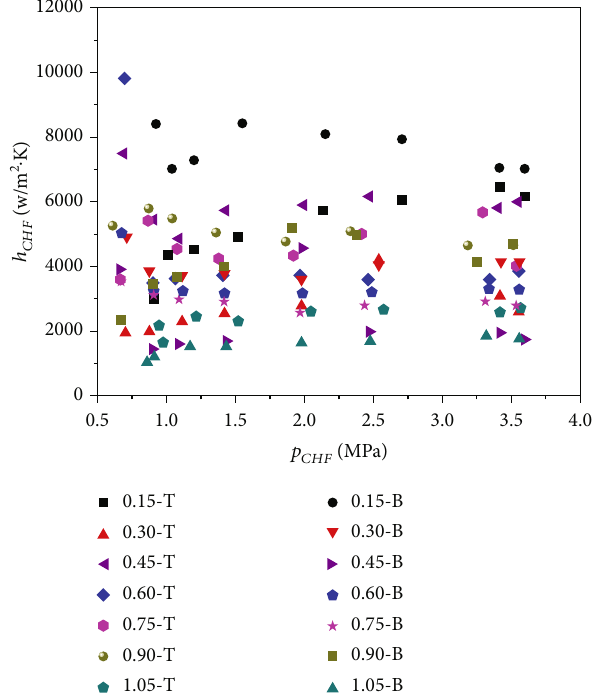
Figure 22: Experimental h